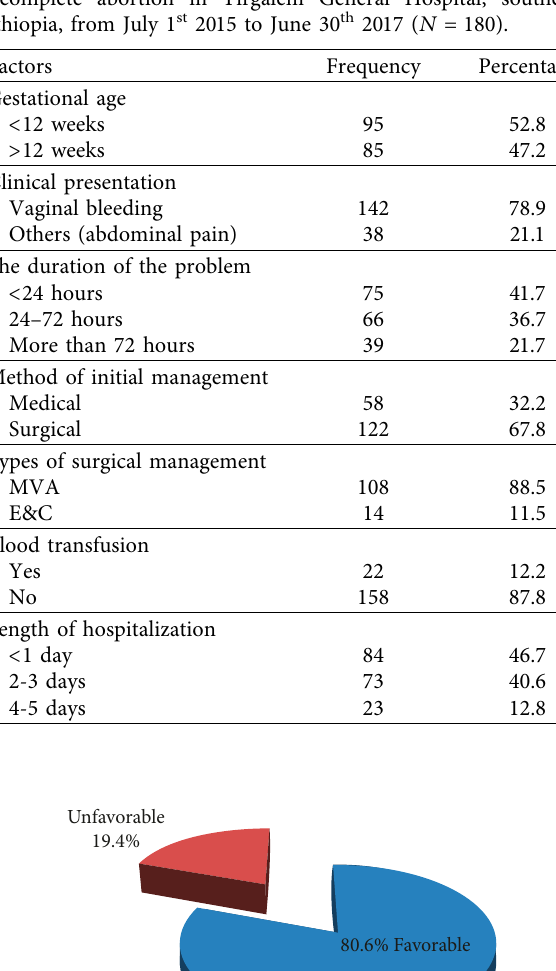
Table 2: Clinical presentation and methods of management of